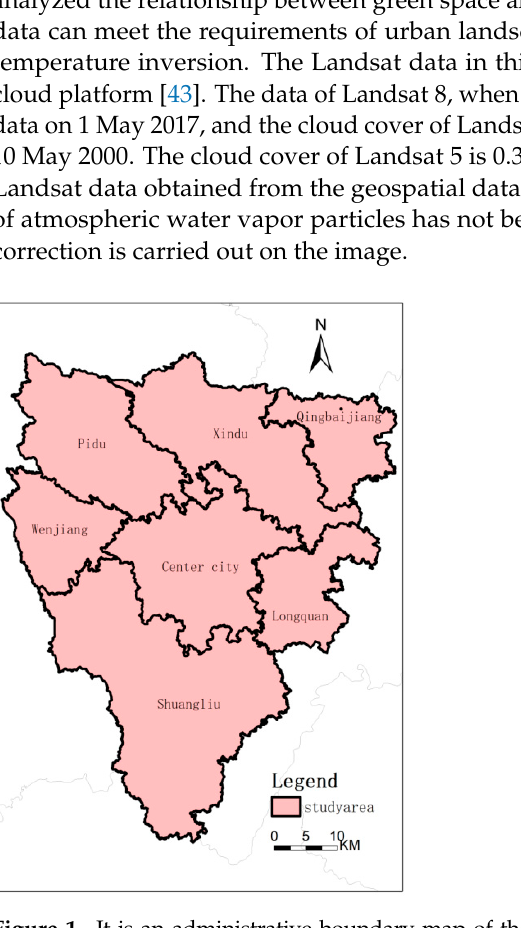
Figure 1. It is an administrative boundary map of the main urban area, including seven secondary administrative regions: Center city, Pidu, Xindu, Wenjiang, Shuangliu, Longquan, Xindu, and